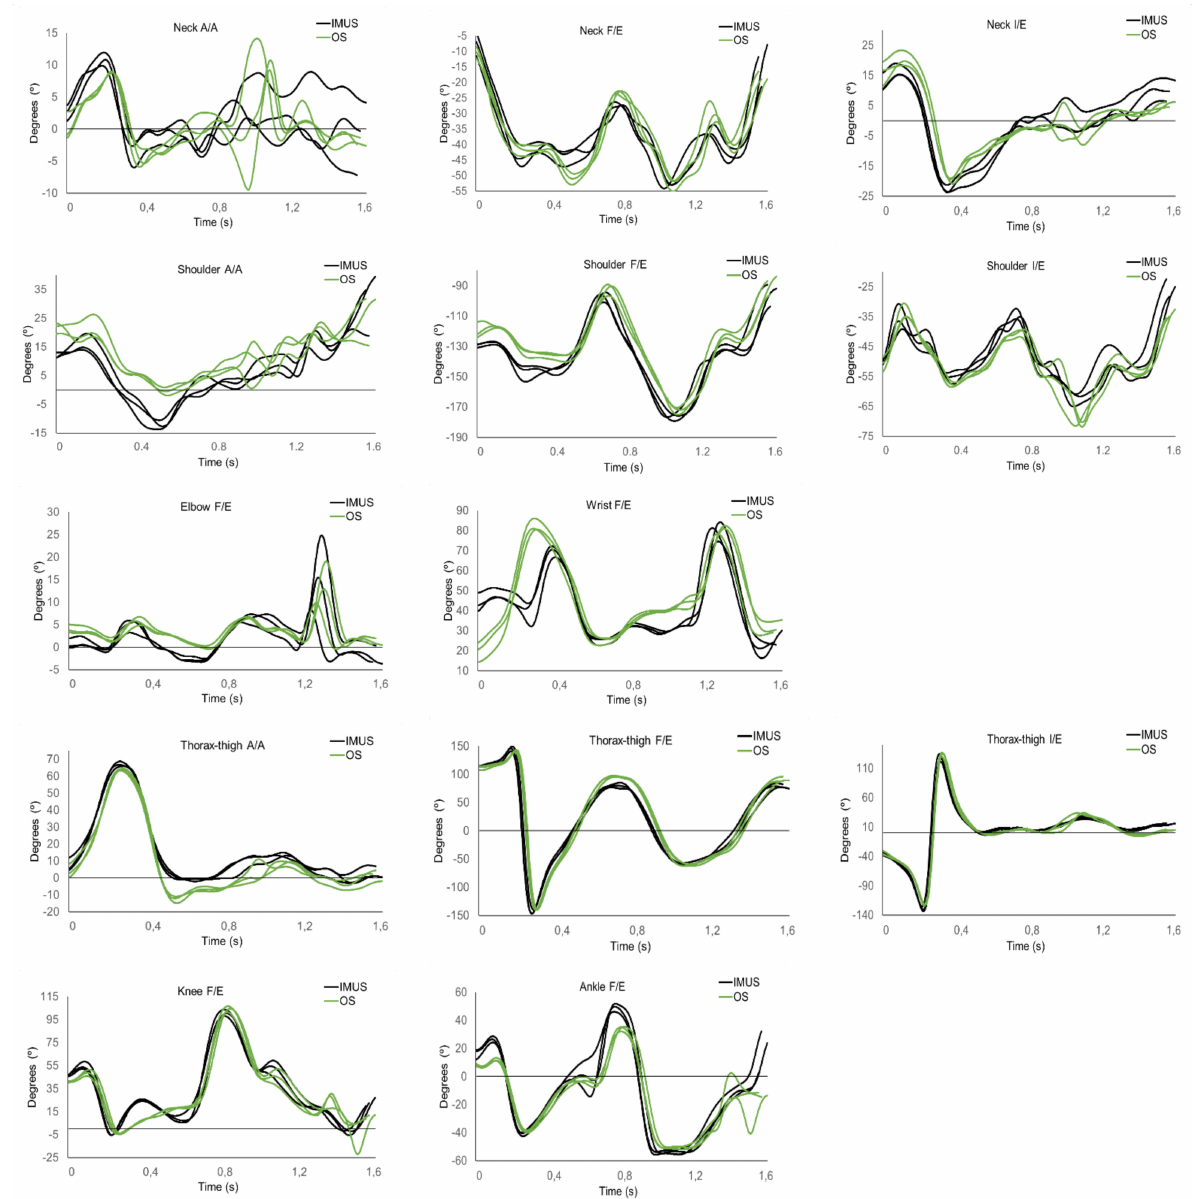
Figure A1. Joint angles measured by IMUS and OS for three trials of round-off back handsprings for one